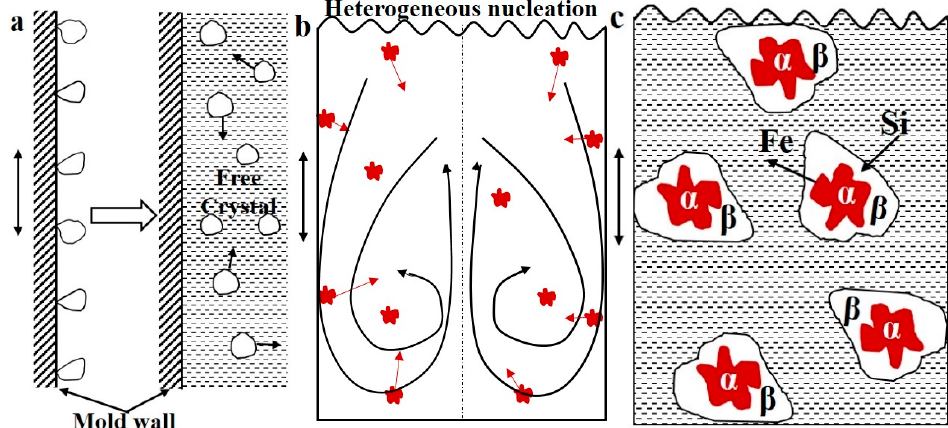
Figure 5. The schematic diagram of the transformation mechanism of iron-rich phase: ( a ) free crystal, ( b ) heterogeneous nucleation, and ( c ) element diffusion in quasi-peritectic reaction.